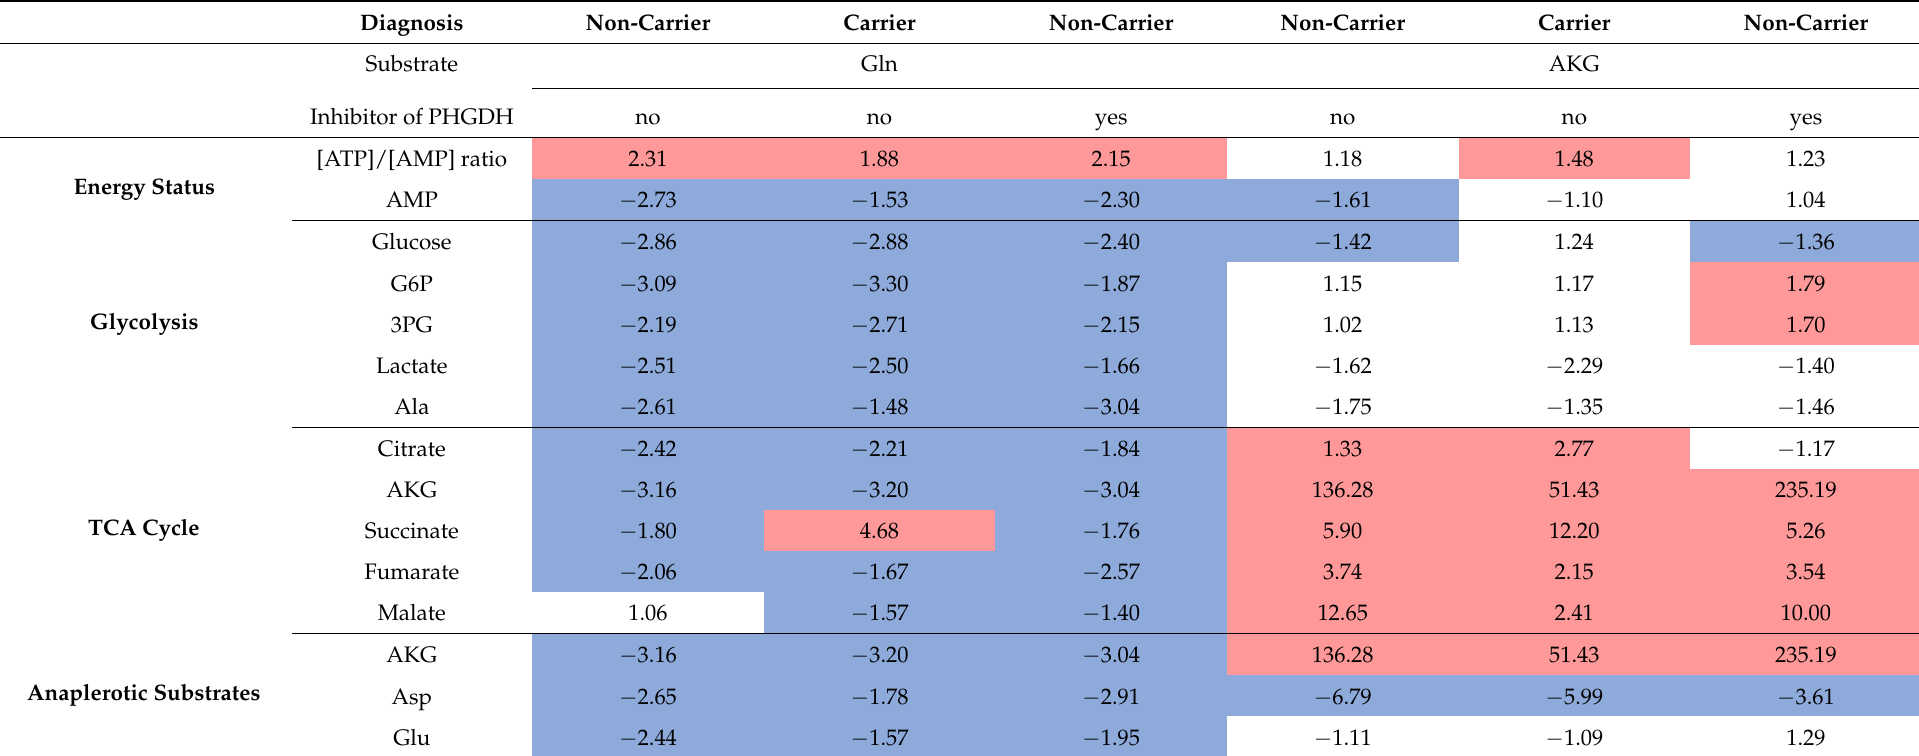
Table 2. Effect of Gln and AKG on the metabolomics of umbilical cord